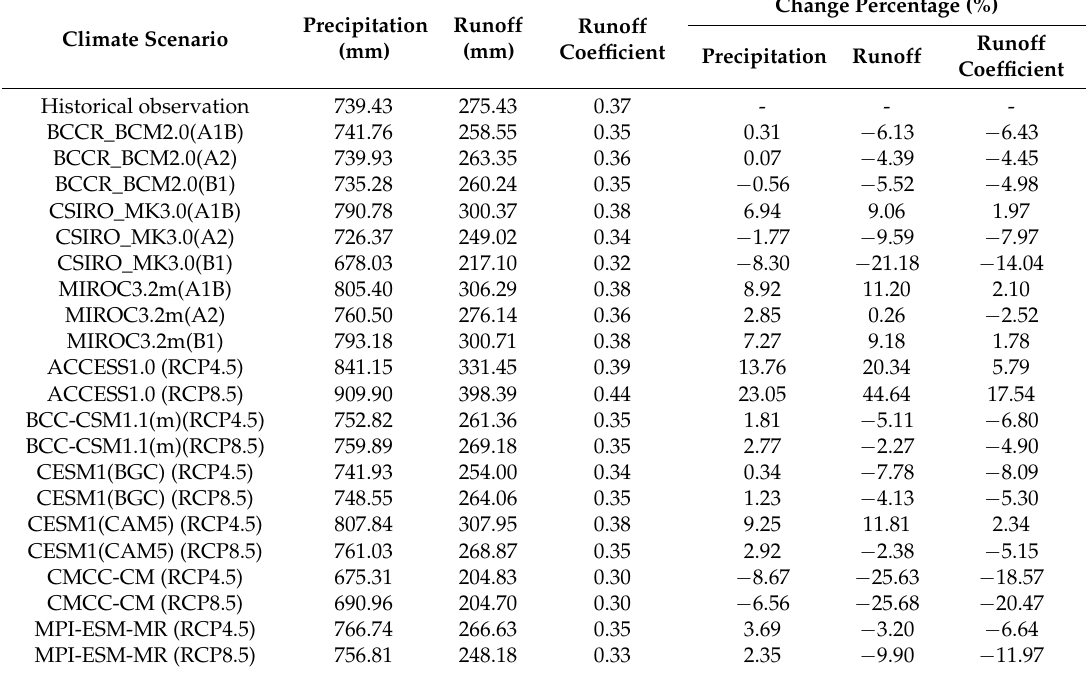
Table 2. Mean annual precipitation and runoff in the historical period (1958–2011) and future period